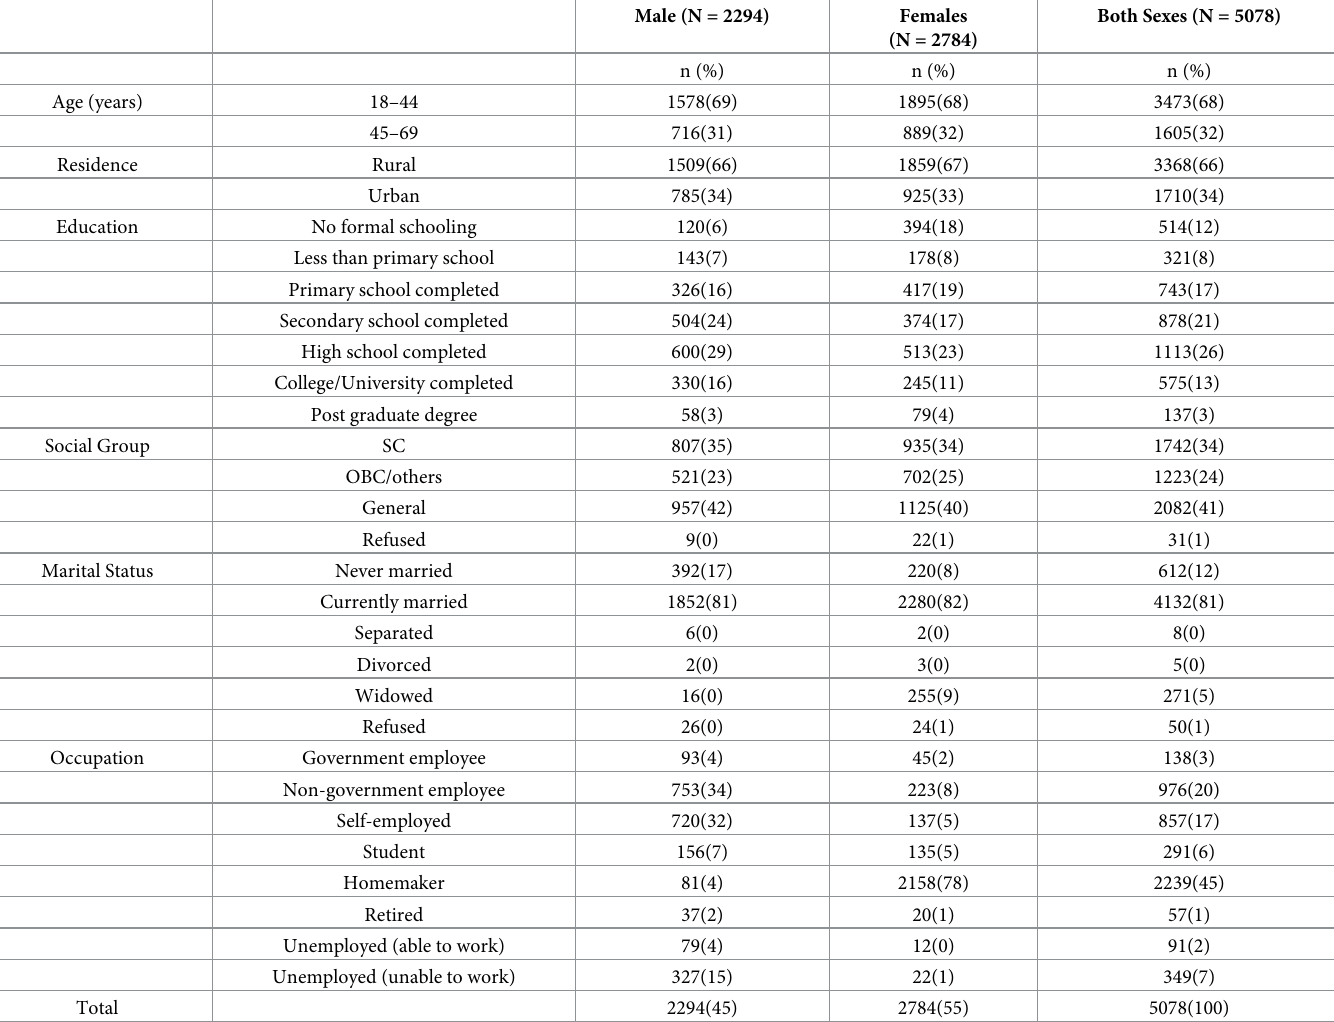
Table 1. Socio-demographic profile of study participants in STEPS Survey, Haryana, India �